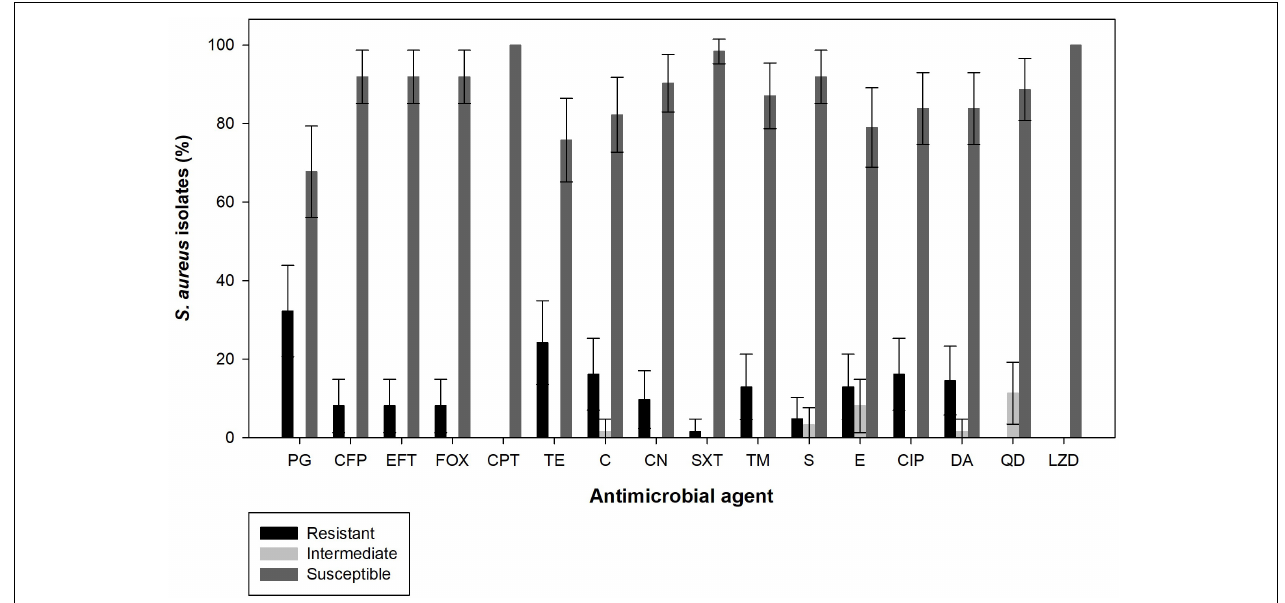
FIGURE 3 | Antimicrobial susceptibility of S. aureus isolated from raw cow’s milk samples collected from bulk cooling tanks of 100 dairy farms located in the from main dairy basin in of mainland Portugal. PG, Penicillin G; FOX, cefoxitin; CPT, ceftaroline; CFP, cefoperazone; EFT, ceftiofur; TE, tetracycline; C, chloramphenicol; CN, gentamicin; SXT, trimethoprim-sulphamethoxazole; TM, trimethoprim; S, sulfonamides; E, erythromycin; CIP, ciprofloxacin; DA, clindamycin; QD, quinupristin-dalfopristin; LZD, linezolid.